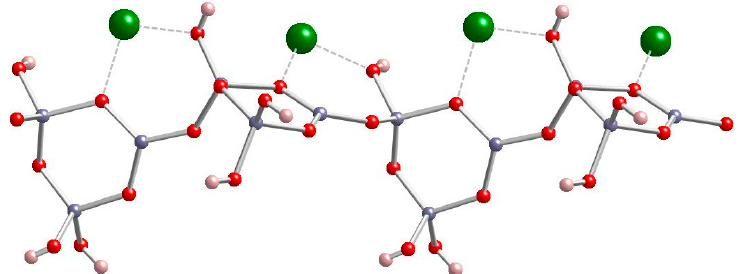
Figure 2. Four repeating units of the polytriborate chain in Zn[B 3 O 4 (OH) 3 ]. (gray = B, red = O, green = Zn, pink = H) [15].